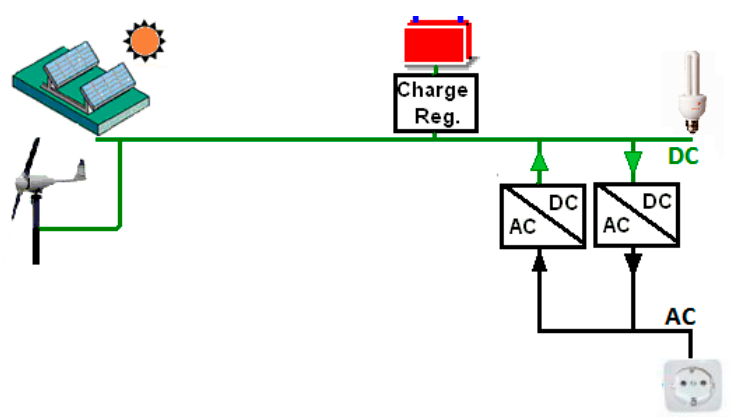
Figure 16. Energy sources used for iHOGA without FC or DG.